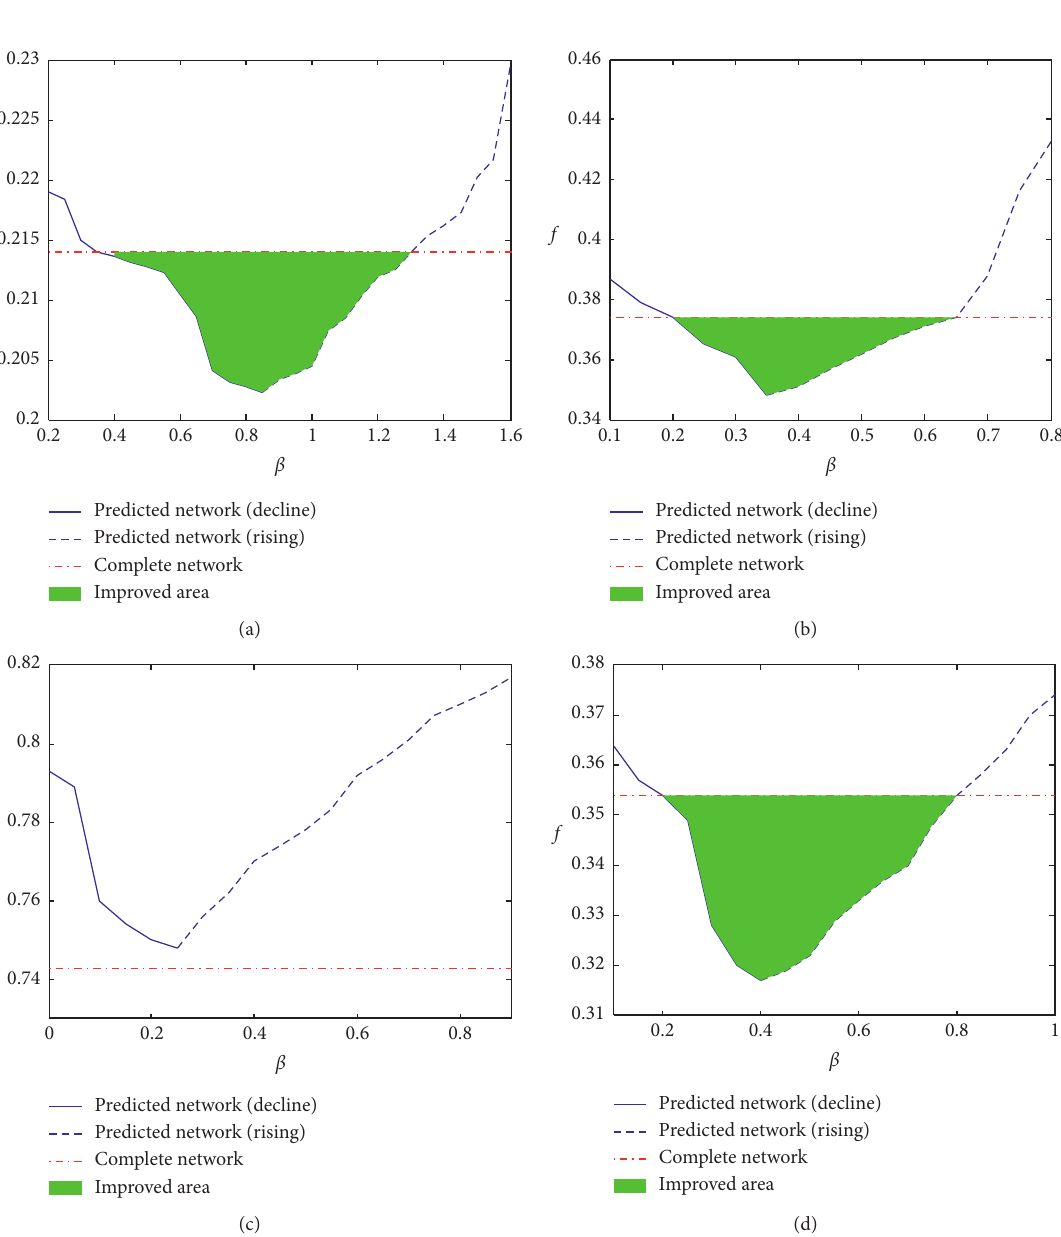
Figure 7: Disintegration evaluation metric as a function of the ratio of additional link information in four real networks when the proportion of the missing links is small ( α � 0.1). (a) ArXiv hep-th network. (b) Cora citation network. (c) Facebook network. (d) Skitter